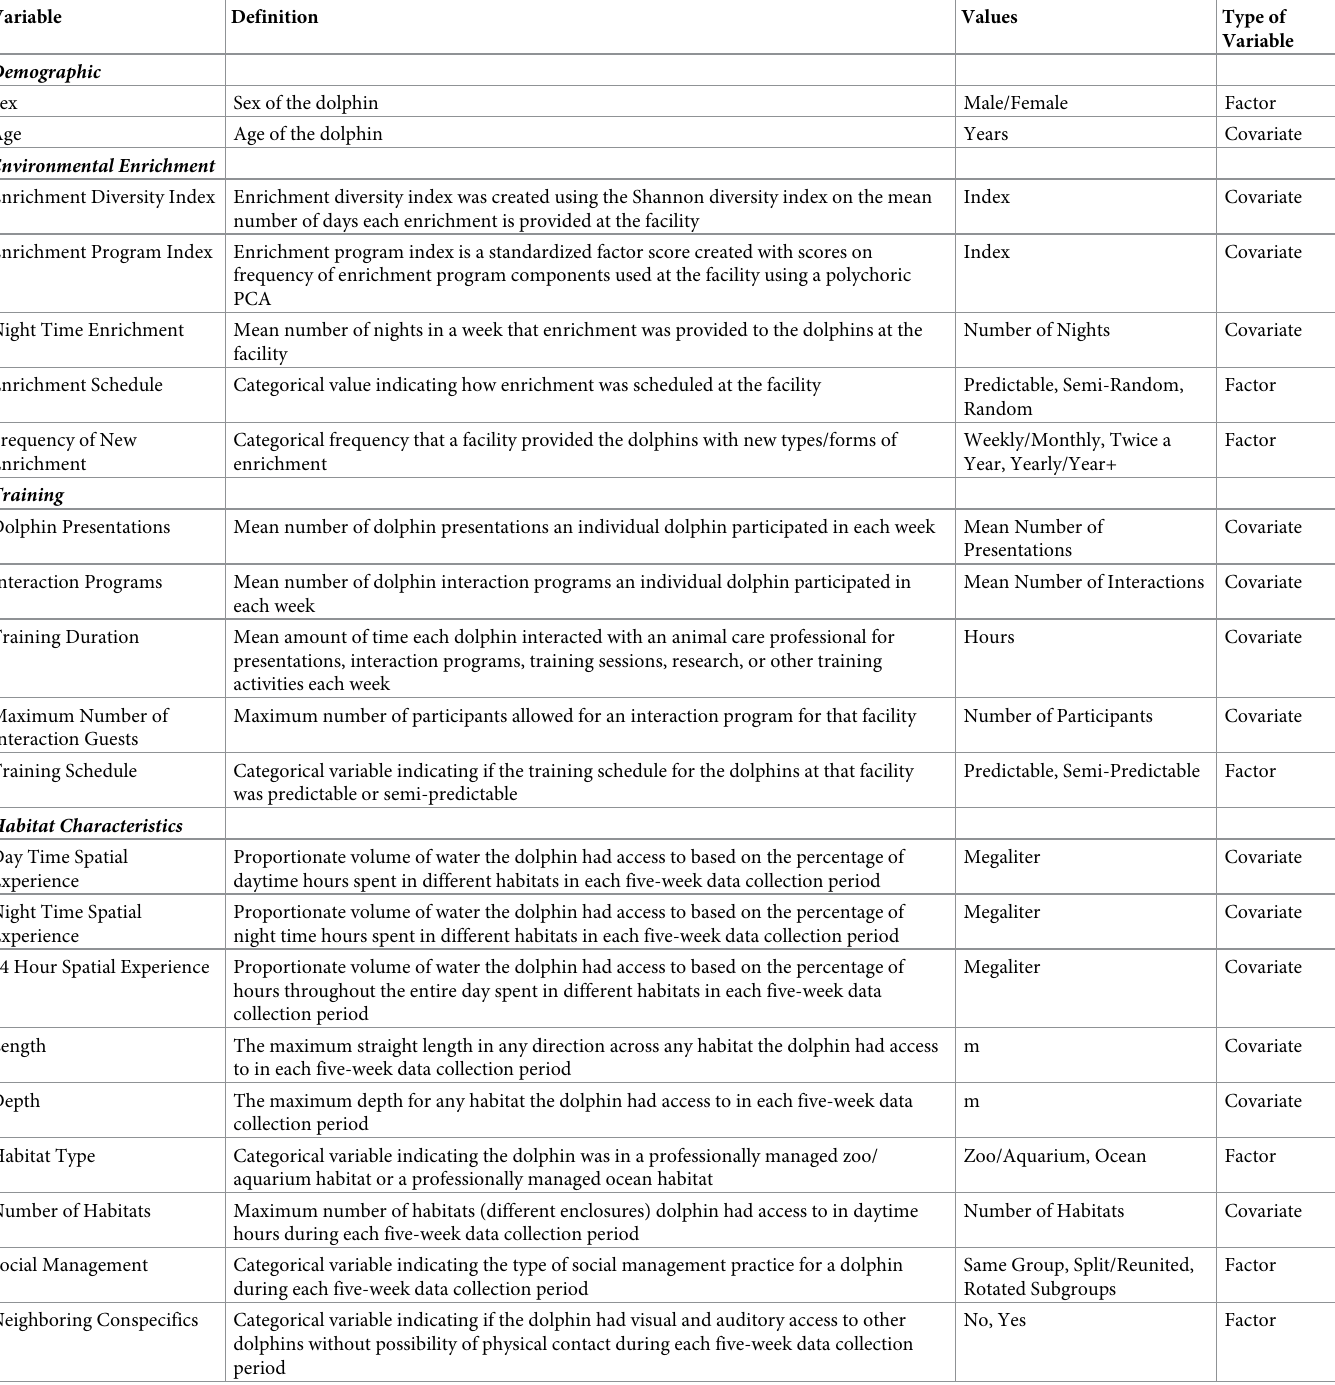
Table 1. Independent variables included in the